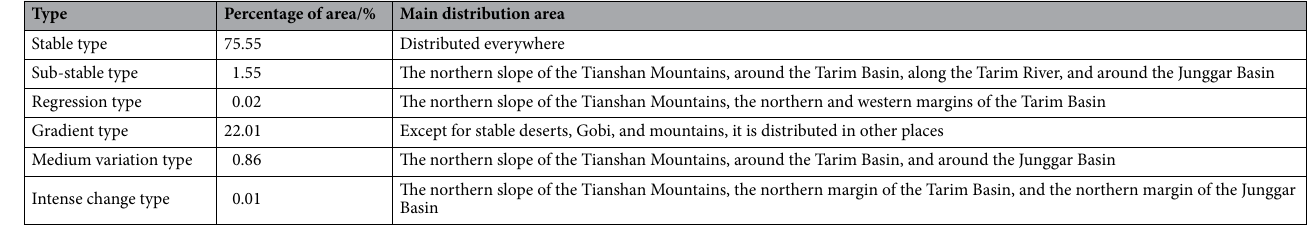
Table 5. Pixel-by-pixel tracking analysis and statistics of five phases of land use change in